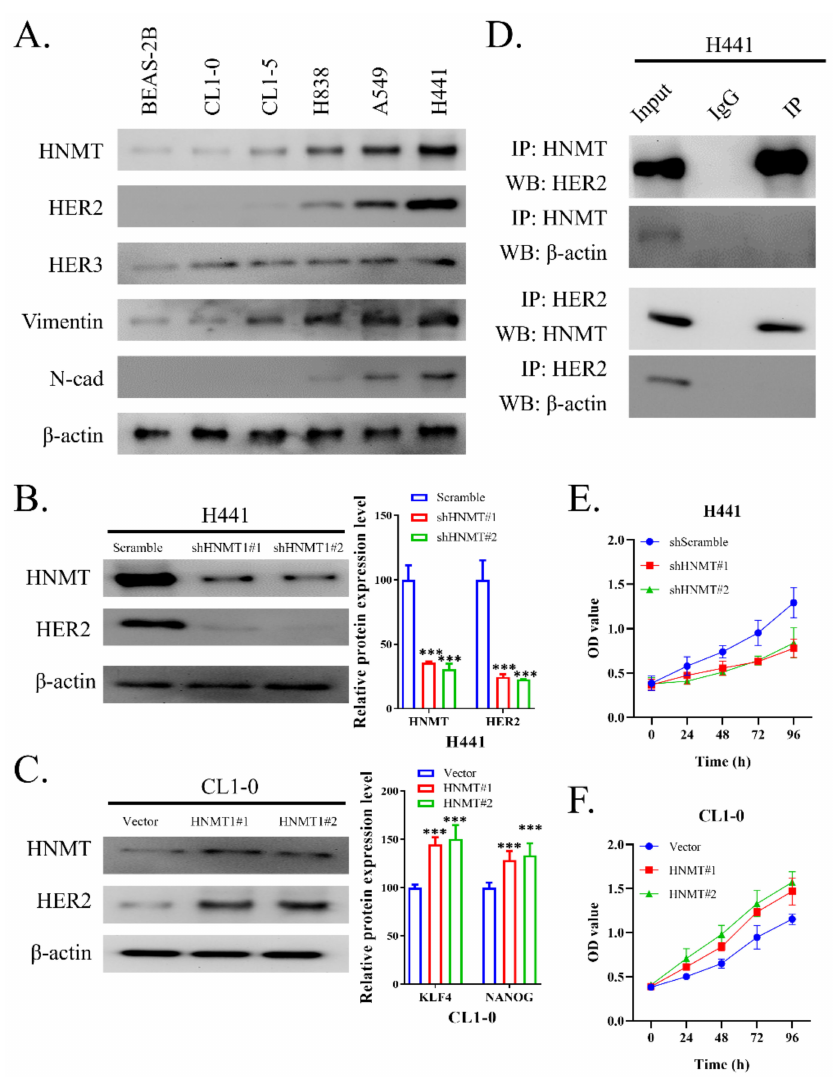
Figure 2. Molecular manipulation effectiveness of HNMT in lung cancer cell lines. ( A ) Western blotting of NSCLC cell lines. Cell lysates from six NSCLC cell lines have been subject to Western blotting. HNMT, HER2, HER3, vimentin, and N-cad were detected using their corresponding antibodies. The experiments were carried out after calibration using GAPDH as an internal control. ( B ) Western blotting for the HNMT and HER2 expression in H441 cells transfected with shScramble, shHNMT#1, or shHNMT#2. ( C ) Western blotting for HNMT and HER2 expression of CL1-0 cells transfected with control vector, HNMT-overexpressing plasmid #1 (pCMV6-HNMT, HNMT#1), or HNMT-overexpressing plasmid #2 (pCMV-HNMT-N1, HNMT#2). Densitometry analysis for the protein expression of both cell lines is provided. ( D ) Coimmunoprecipitation was used to detect HNMT–HER2 interaction and β -actin were used as a housekeeping control. ( E ) Cell proliferation growth curve comparison of H441 cells transfected with shScramble, shHNMT#1, or shHNMT#2, and ( F ) CL1-0 cells transfected with vector control or control vector, HNMT-overexpressing plasmid #1 (HNMT#1), or HNMT-overexpressing plasmid #2 (HNMT#2). *** p <